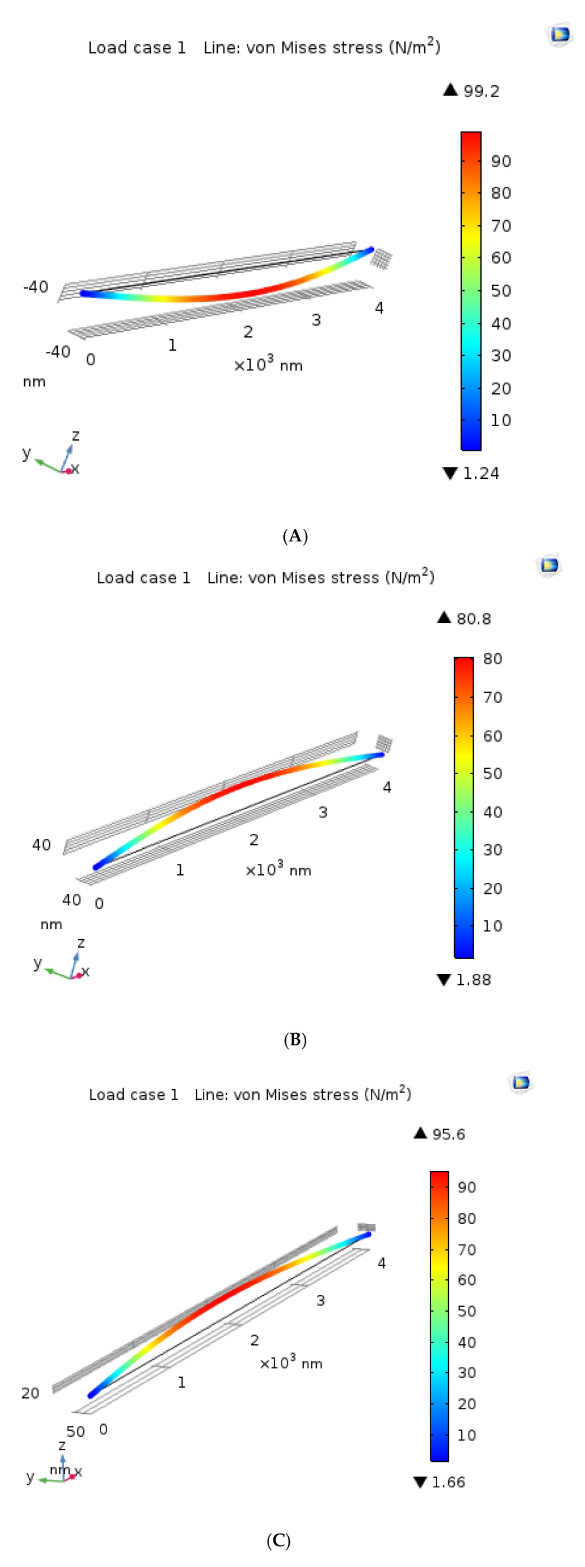
Figure 3. The Finite Element Analysis for the Two Cross-Sections on Structural Strength. ( A ) Maximum Induced Stress of Graphite Sheet Nanotube Section; ( B ) Maximum Induced Stress of Graphite Sheet Wide Flange Nano-I-beam Section; ( C ) Maximum Induced Stress of Graphite Sheet Equal Flange & Web Nano-I-beam